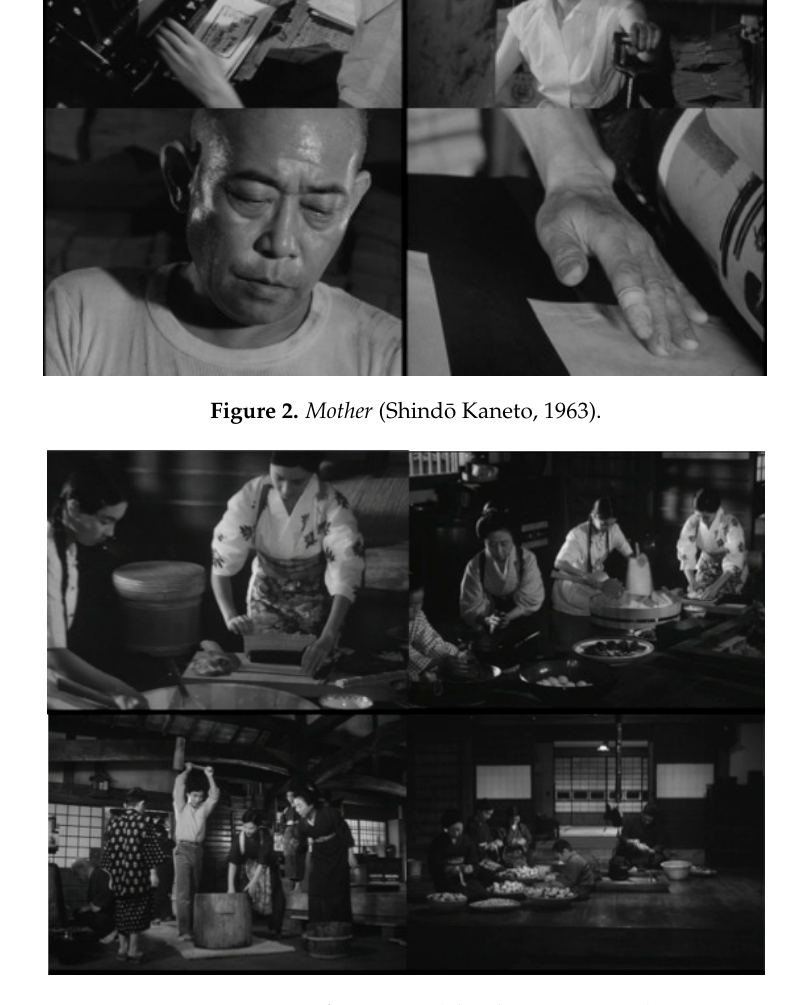
Figure 3. Tree Without Leaves (Shind ō Kaneto, 1986).